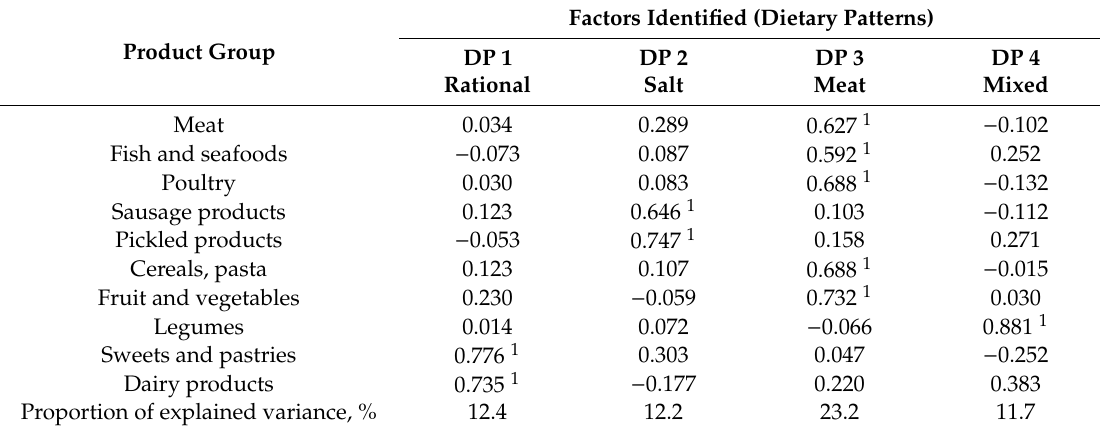
Table A18. Factor loadings of the principal dietary patterns identified (Tyumen region).